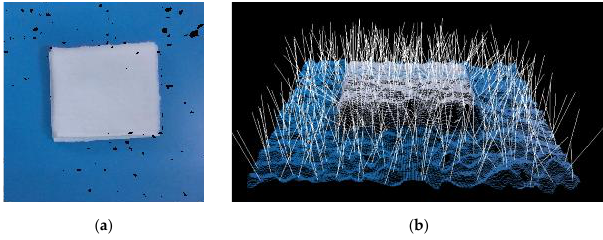
Figure 2. The sign of the normals: ( a ) the point clouds of the towel on a table; ( b ) the point clouds of the towel and its normals.